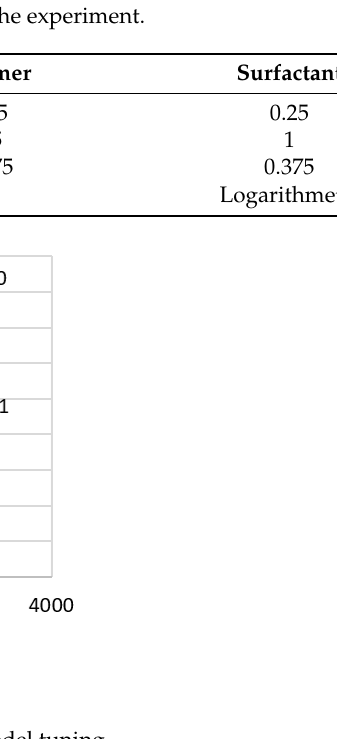
Figure 16. Result of model tuning to experimental data (surfactant and polymer yields). Table 5. Parameters obtained by tuning the model to the experiment.